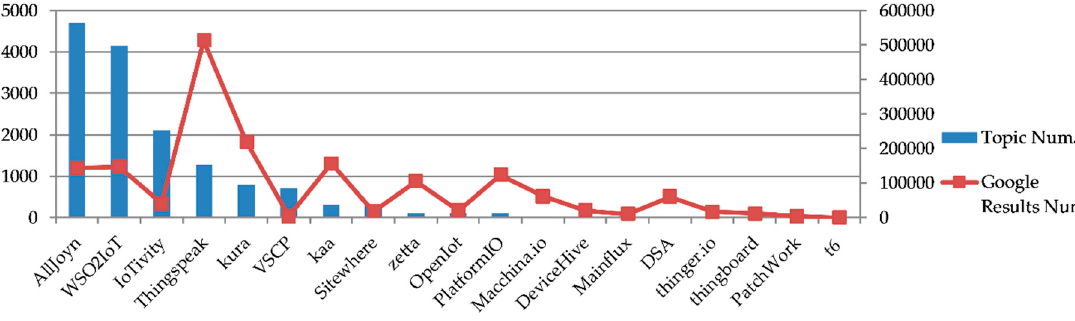
Figure 2. Key features of open source middleware for the IoT.